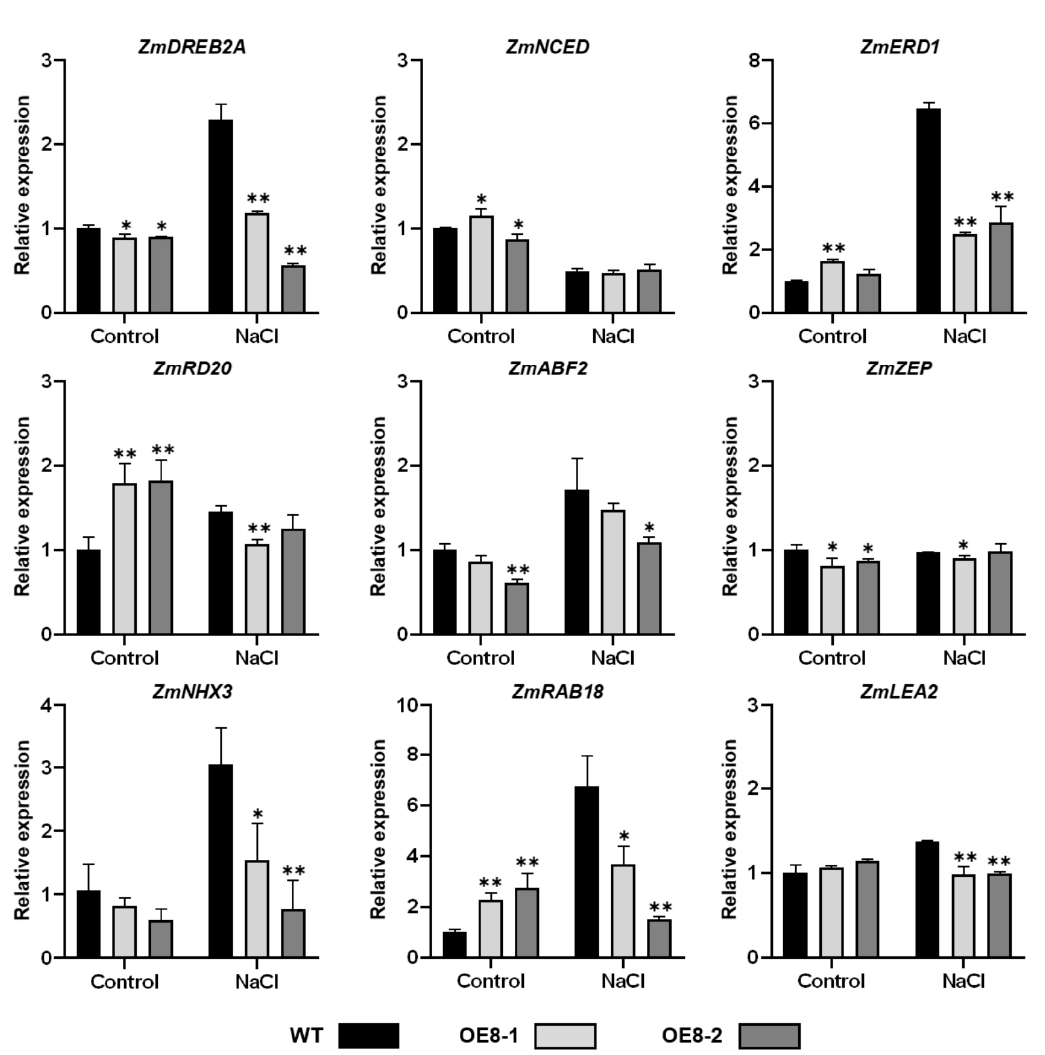
Figure 6. Expression patterns of stress-responsive genes in WT and ZmHsf08 -overexpressing plants under normal condition and NaCl treatment. Three-leaf stage maize seedlings were treated with 200 mM NaCl for 7 days. The expression levels of stress-responsive genes during salt stress were analyzed by RT-qPCR. Values are means ± SD. Bars represent means ± SD ( n = 3 repeats). Significant differences (Student’s t test): *, p < 0.05, **, p < 0.01.